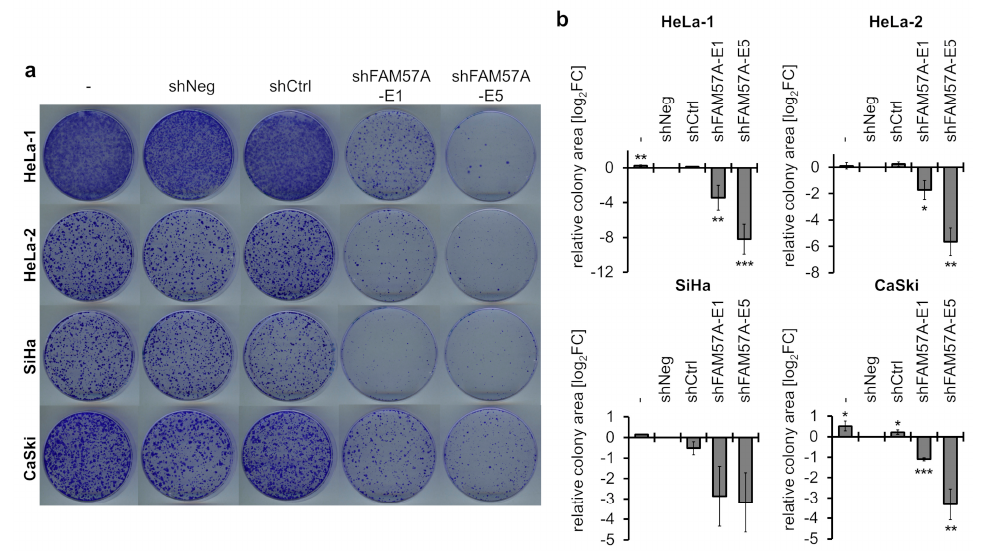
Figure 5. Effects of FAM57A silencing on the colony formation capacity of HPV-positive cancer cells. ( a ) Colony formation assays (CFAs) in cervical cancer cell lines expressing FAM57A -silencing shRNAs shFAM57A-E1 or shFAM57A-E5 (please also refer to Figure S6a), or two different control shRNAs, shNeg, or shCtrl. (-), empty vector control. Depending on the cell line, cells were grown for 10–15 days and colonies were visualized by staining with crystal violet. ( b ) Quantification of corresponding CFAs (relative colony areas). The presented data are log 2 -transformed and derived from 3 independent CFA analyses of HeLa-1, HeLa-2, and CaSki cells, and from 2 independent CFA analyses of SiHa cells. Standard deviations are indicated. Statistical analyses were performed for HeLa-1, HeLa-2, and CaSki cells. Statistically significant differences are determined relative to shNeg-transfected control cells (log 2 FC = 0) by one-way ANOVA. *: p < 0.05, **: p < 0.01, ***: p < 0.001.